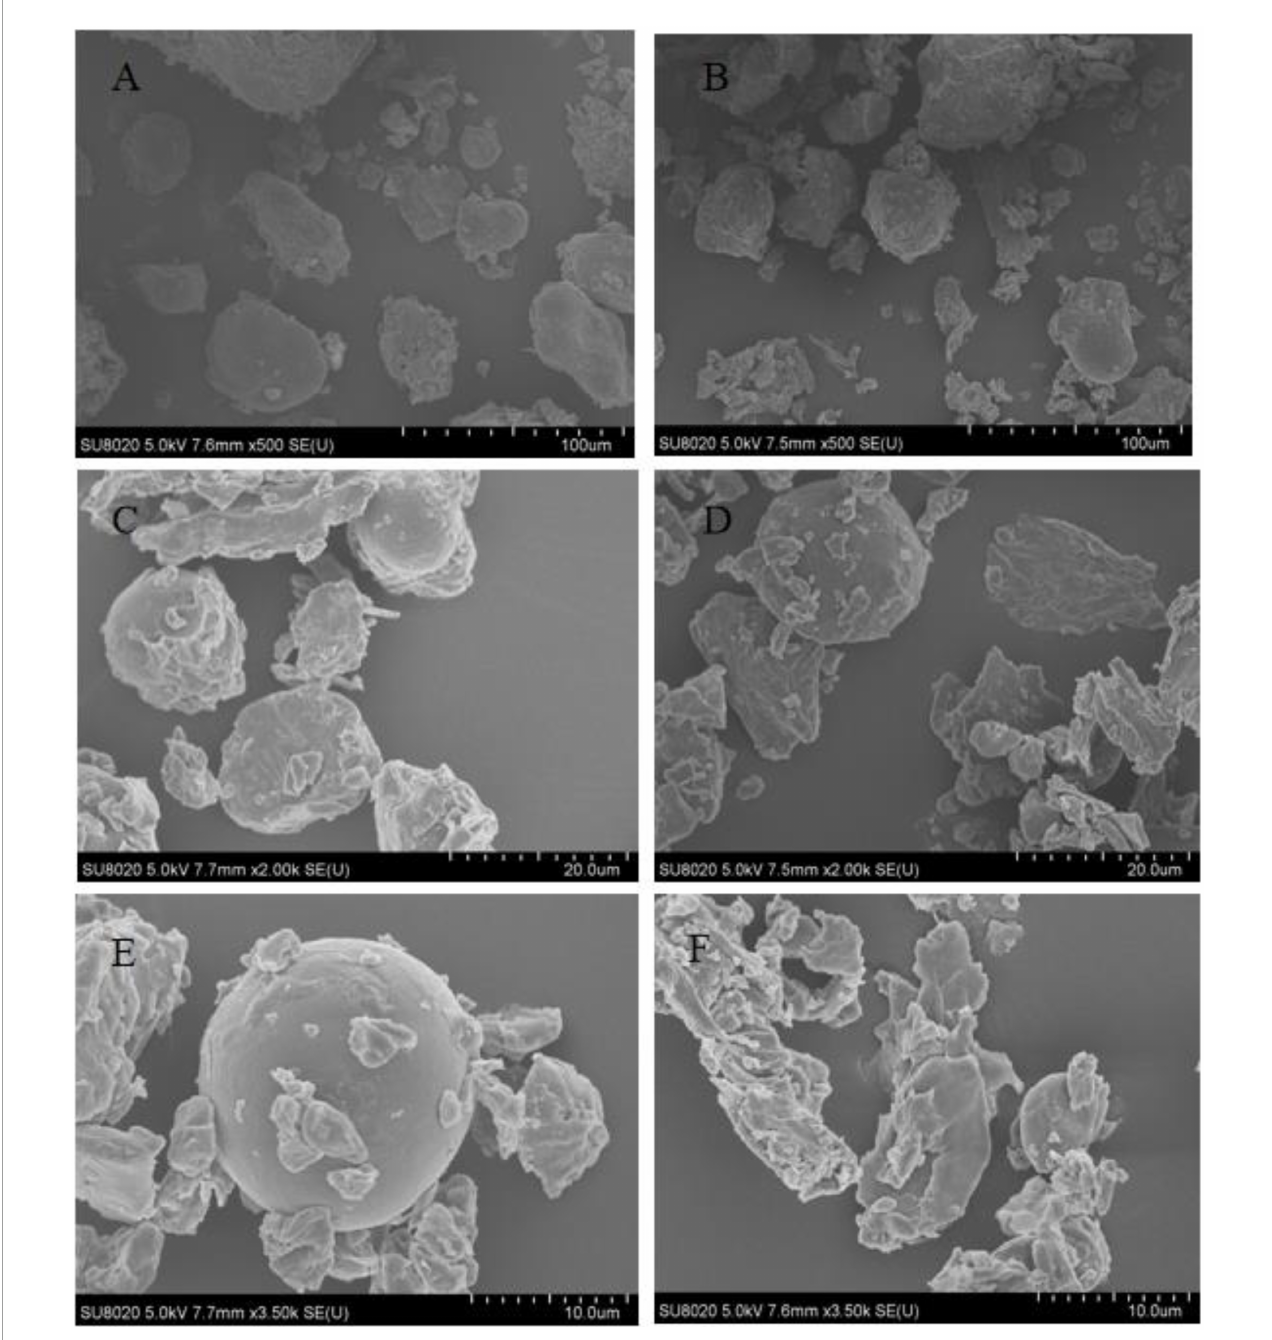
FIGURE2 Scanning electron microscope (SEM) images of adzuki bean before and after germination. (A) Original adzuki bean ( × 500), (B) Germinated adzuki bean ( × 500), (C) Original adzuki bean ( × 2000), (D) Germinated adzuki bean ( × 2000), (E) Original adzuki bean ( × 3500), (F) Germinated adzuki bean ( ×